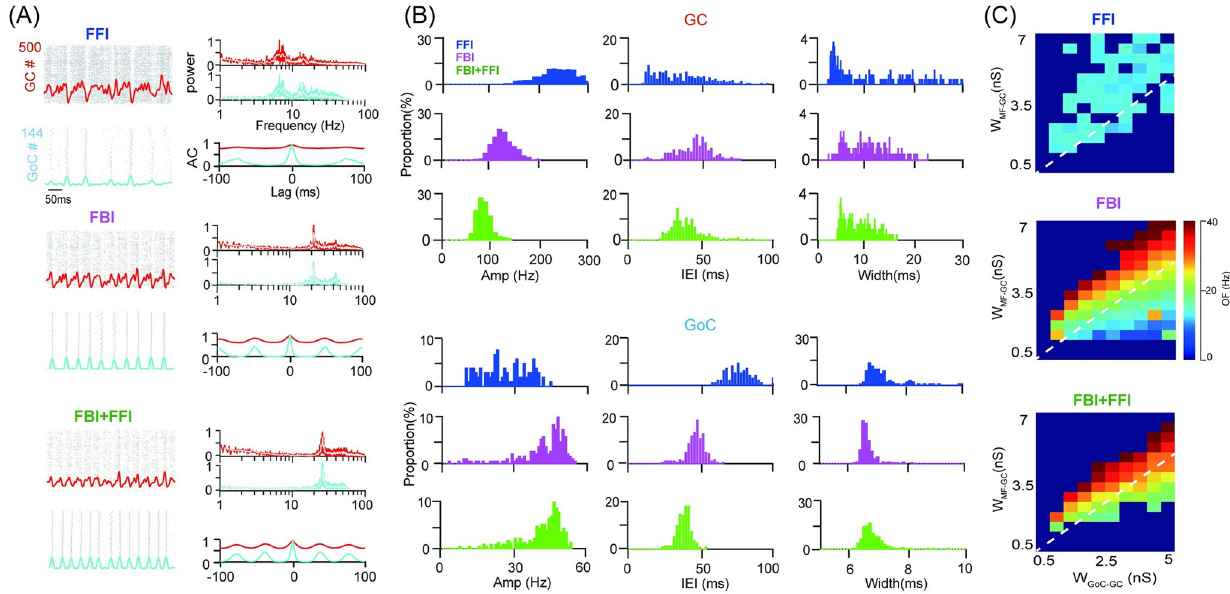
Fig 4. Oscillation reinforced by gap junction. (A) Spike raster and population firing rate of GCs and GoCs (left), and the corresponding power spectrum and auto-correlation (AC) of population firing rate (right) in three scenarios with gap junction and GoC-GC STP included. (B) Oscillation metrics characterized by the amplitude (Amp), inter-event interval (IEI) and width. Histograms of three metrics for GC (top) and GoC (bottom). (C) Modulation of the oscillation frequency over increasing excitatory (E) W MF and inhibitory (I) W GoC strengths. The white dash line indicates the ratio of − GC − GC excitation and inhibition as